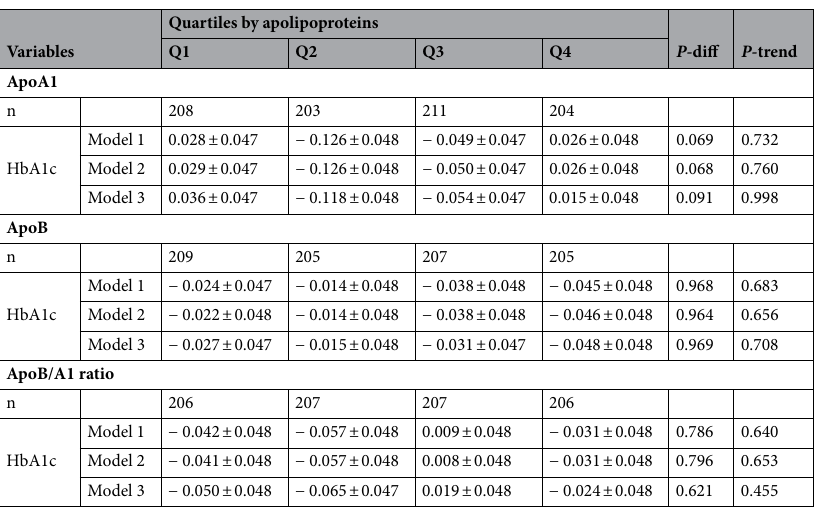
Table 4. Changes in HbA1c level over ~ 4 year by quartiles of apolipoprotein in all participants (mean ± SE). Apo apolipoprotein, HbA1c glycosylated hemoglobin, Q quartile. P -Diff: Multiple comparison among quartiles. Model 1 was univariate analysis. Model 2 was adjusted for sex, age. Model 3 further adjusted for BMI, education, marriage, exercise, cigarette smoking, alcohol consumption, hypoglycaemic agent, and lipid- lowering drugs use.